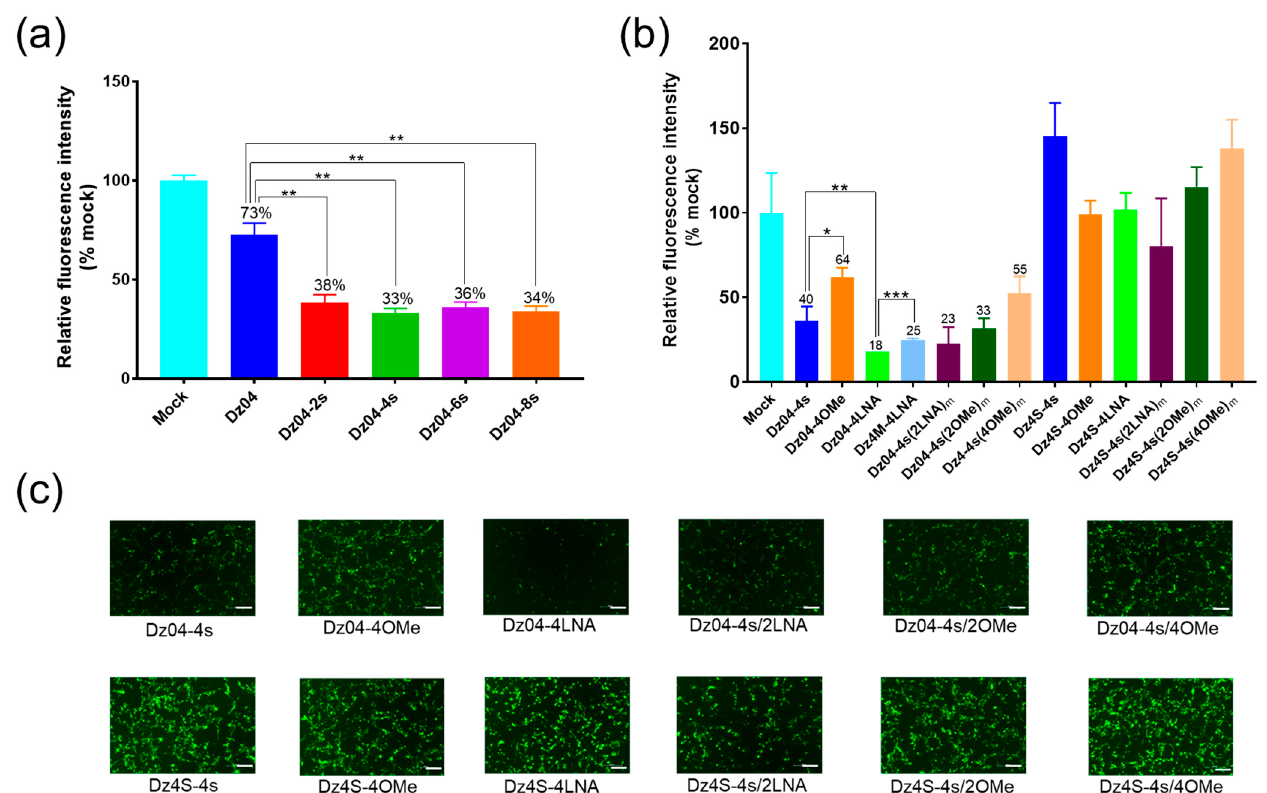
Figure 6. The modified DNAzyme (Dz04) with high gene-silencing effect in cells. ( a ) Effect of Dz04 PS modifications on gene silencing. Statistical significance was determined by a Student’s t -test of three repeats (** p < 0.01). ( b ) Gene silencing of Dz04 with different chemical modifications. The fluorescent data significance was determined by a Student’s t -test (* p < 0.05, ** p < 0.01, *** p < 0.001). Dz04-4s, Dz04-4OMe and Dz04-4LNA contained two PS, OMe and LNA modifications at both 5 (cid:48) and 3 (cid:48) ends of Dz04, respectively. Dz04-4s(2LNA)m contained one LNA in the middle of each Dz04-4s arm. Dz04-4s(2OMe)m and Dz04-4s(4OMe)m contained one and two OMe modifications in the middle of